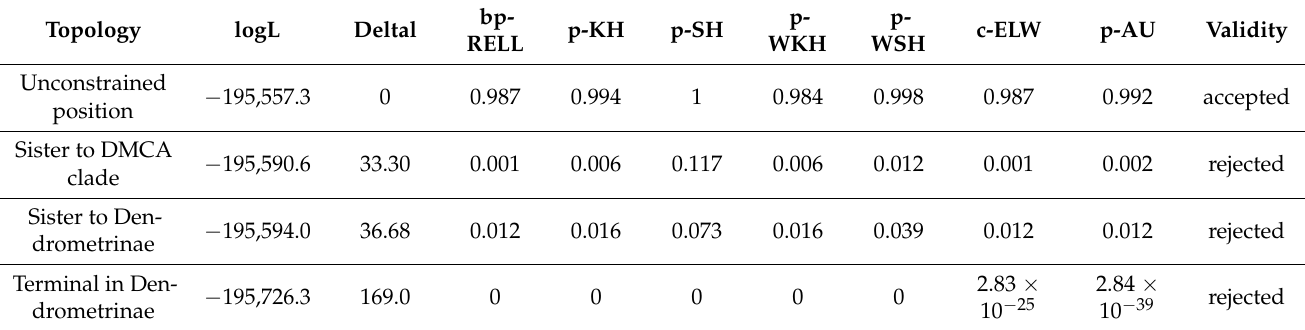
Table 2. Results of likelihood test constrained trees versus an unconstrained tree. DMCA clade—a clade containing Den- trometrinae, Morostomatinae, Cardiophorinae, and Agrypninae; deltaL—logL difference from the maximal logl in the set; bp-RELL—bootstrap proportion using RELL method; p-KH— p -value of one-sided Kishino–Hasegawa); p-SH— p -value of